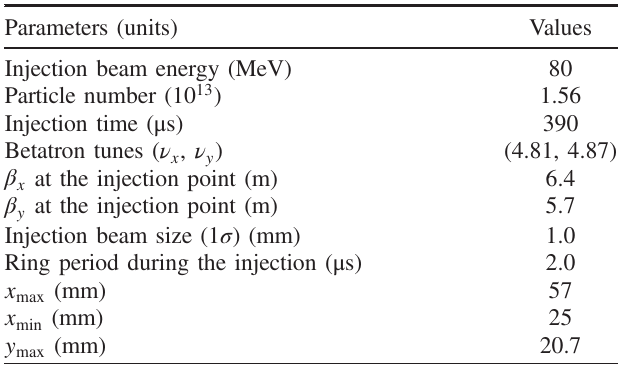
TABLE II. Injection-related parameters for the